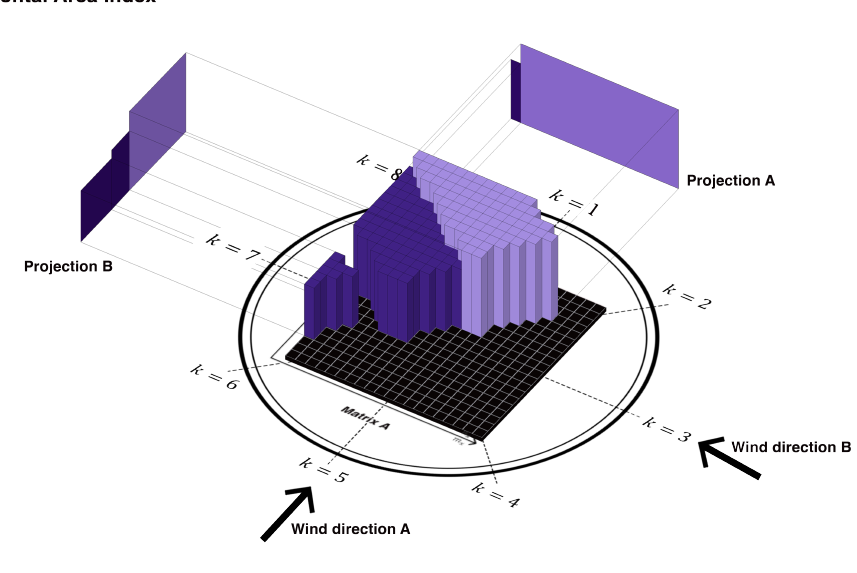
Figure 4. Projection of the maximum M k values into vertical 2D planes to calculate FAI in the direction θ k